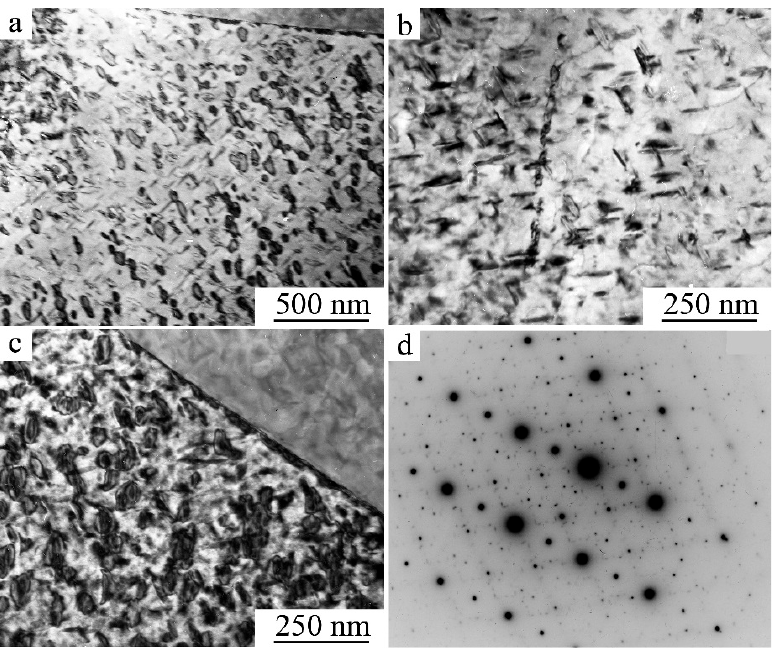
Figure 17. ( a – c ) Bright-field TEM images of the microstructure, and ( d ) the corresponding SAED pattern (z.a. [210] B 2 , SD 1.0 µm), of the Ti 49 Ni 51 alloy after HT at 773 K for 1 h.